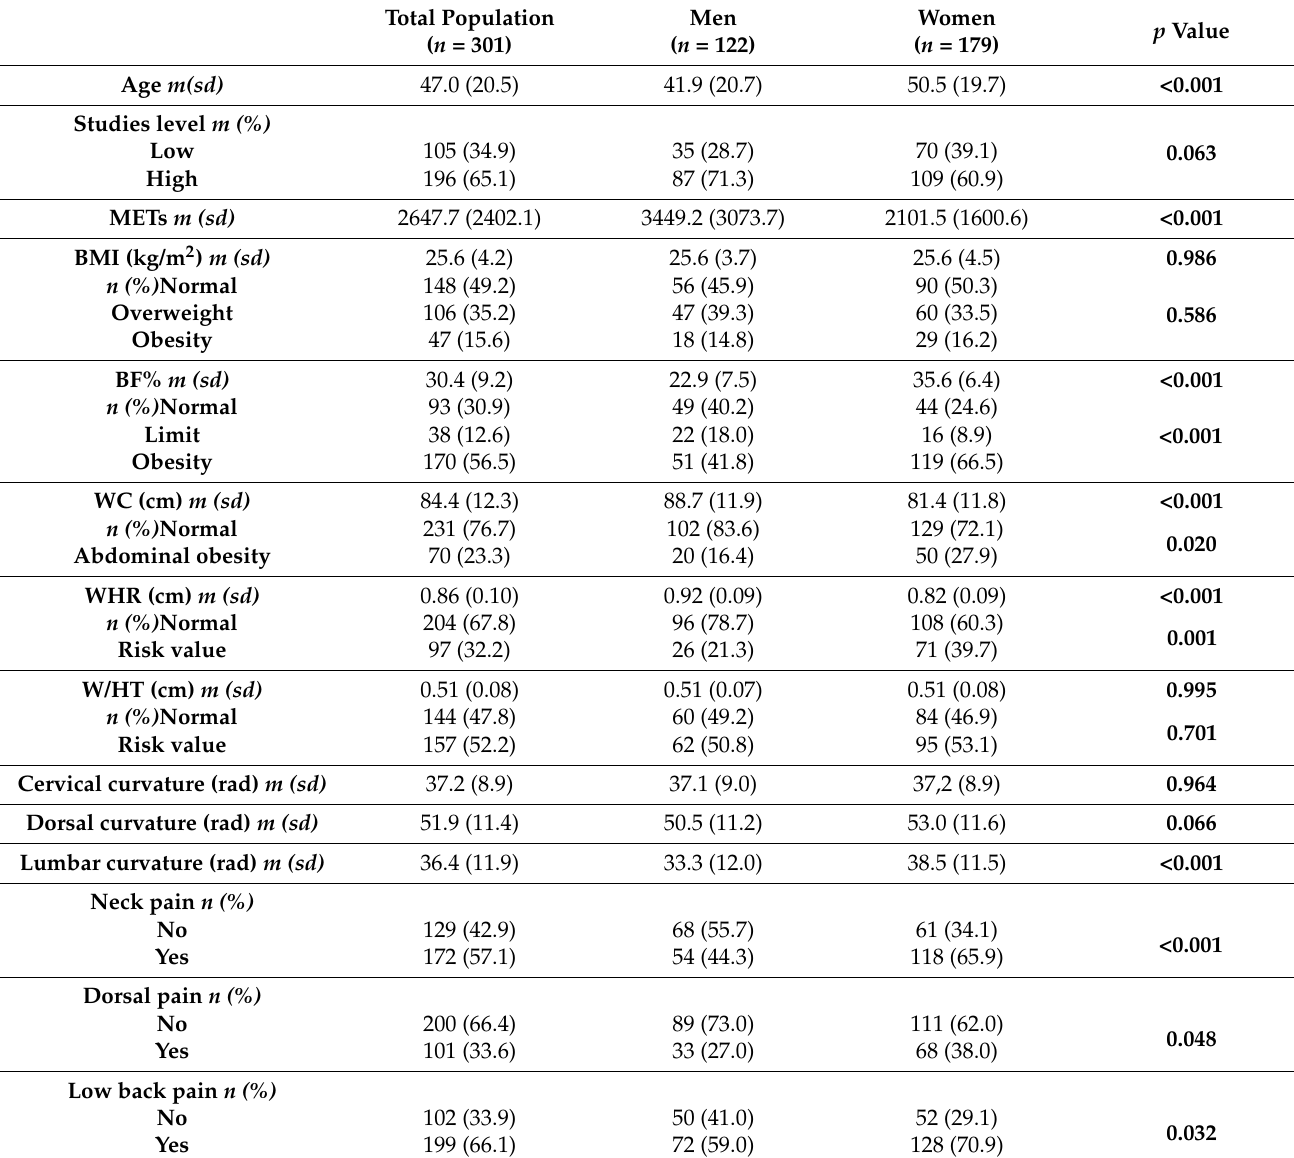
Table 1. Descriptive characteristics of the total population and according to